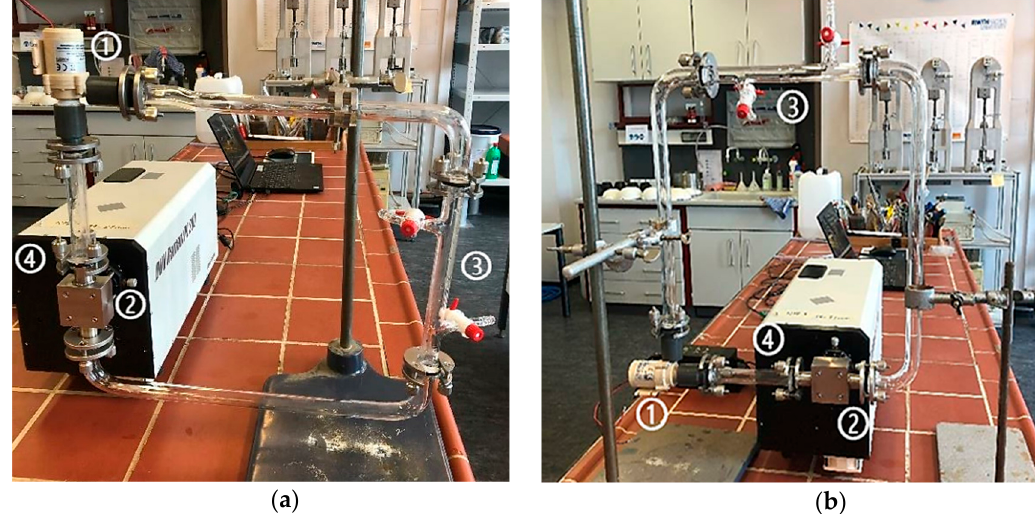
Figure 5. Flow cell construction in the vertical direction ( a ) and horizontal direction ( b ) with pumping, (1) pump, (2) flow cell, (3) inlet and outlet, (4) laser ‐ spectrometer.